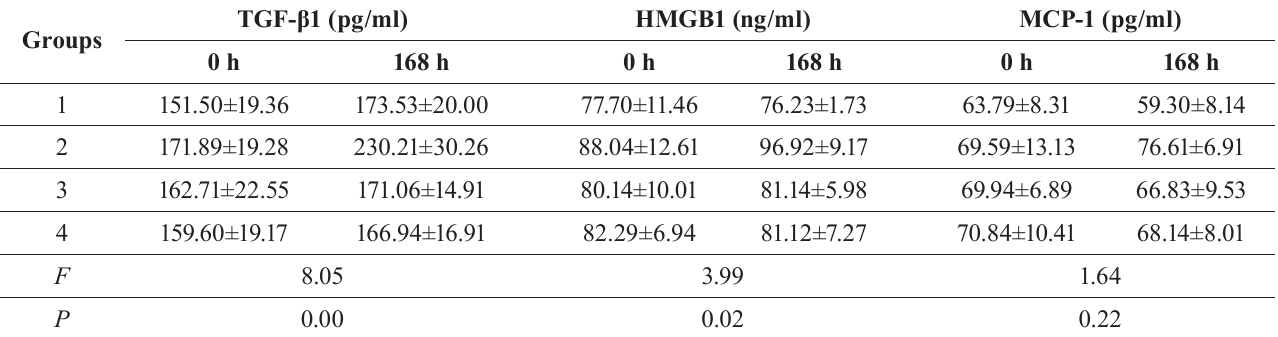
TABLE IV - Cytokines changes of groups ( )